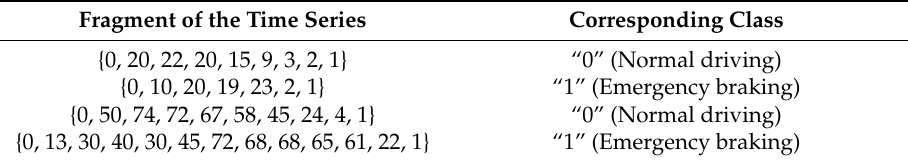
Table 4. Sample fragments of the time series of the position of accelerator pedal (in percent).